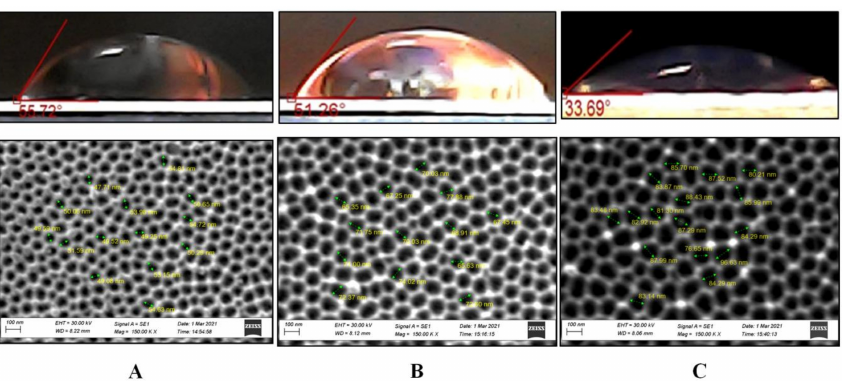
Figure 8. Contact angle as a surface topology function for as-fabricated samples No. 4 ( A ), 5 ( B ), and 6 ( C ) of the II type and corresponding SEM images of outer surfaces.